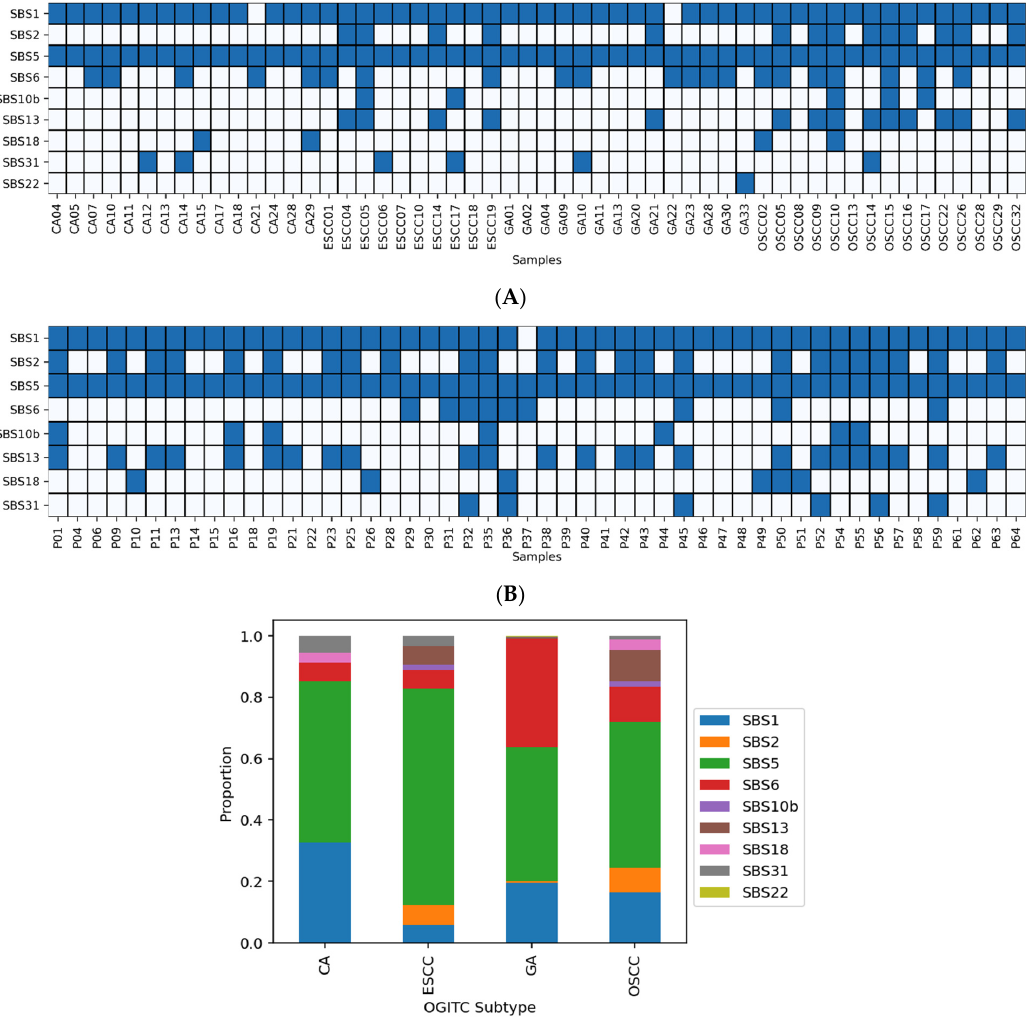
Figure 2. Mutational spectrum for GA33 with A to-T transversions with a weakly associated tran- scriptional strand bias in the C[T > A]G trinucleotide context.